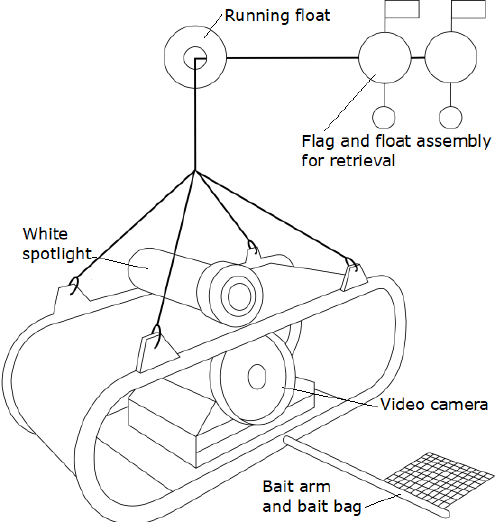
Figure 3. Illustration of Baited Remote Underwater Video Station unit for deepwater (<300 m) deployments. A high-definition video camera was in a water-tight housing and an additional white spotlight above the camera aided species identification. Bait arm of plastic mesh filled with ~1 kg of crushed pilchards extended into the camera’s field-of-view. At surface-level, there was a flag-float assembly for retrieval and a running float was used to keep track of the slack line. This figure is a schematic not drawn to scale.